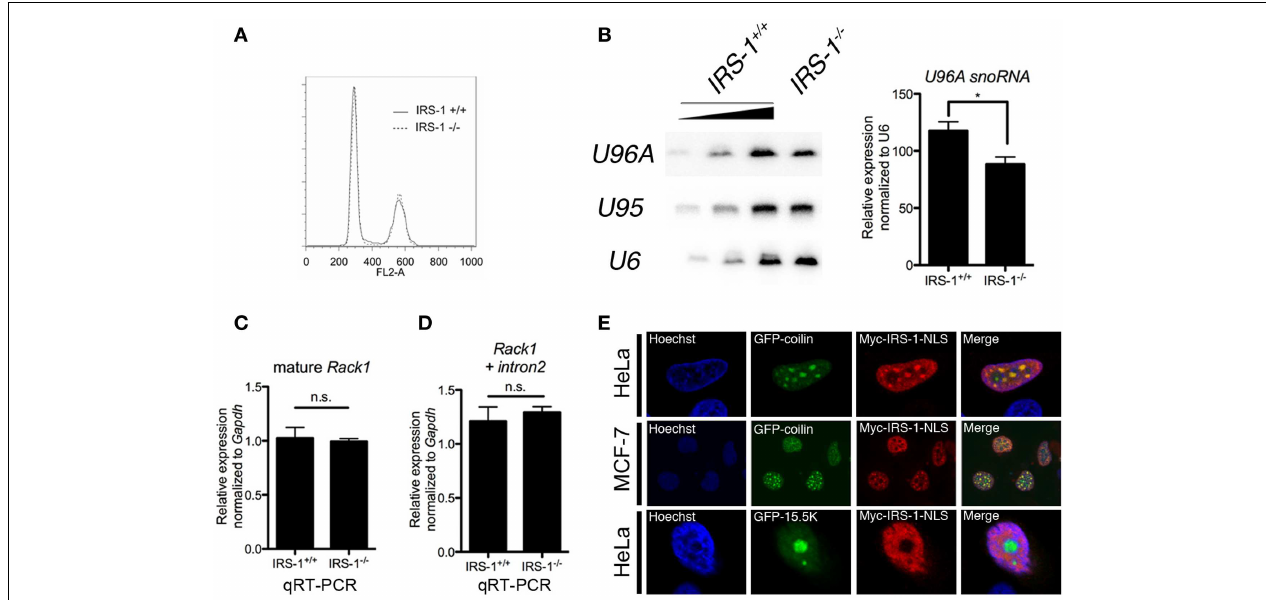
indicate SEM. * P < 0.05 (Student’s t -test). (C,D) Relative expression of mature Rack1 mRNA and Rack1 pre-mRNA retaining intron2 in MEFs from IRS-1 + / + and IRS-1 − / − animals. n = 5, bars indicate SEM. n.s., non-significant (Student’s t -test). (E) HeLa cells and MDF-7 cells were co-transfected with the plasmids expressing Myc–IRS-1 and either GFP–coilin (Cajal body marker) or GFP-15.5K (nucleolus marker). Following serum-starvation, cells were fixed and stained with anti-Myc antibody and Hoechist33342. A merge of the two images is shown with yellow indicating areas of colocalization. Representative stainings from at least three experiments using each cell are